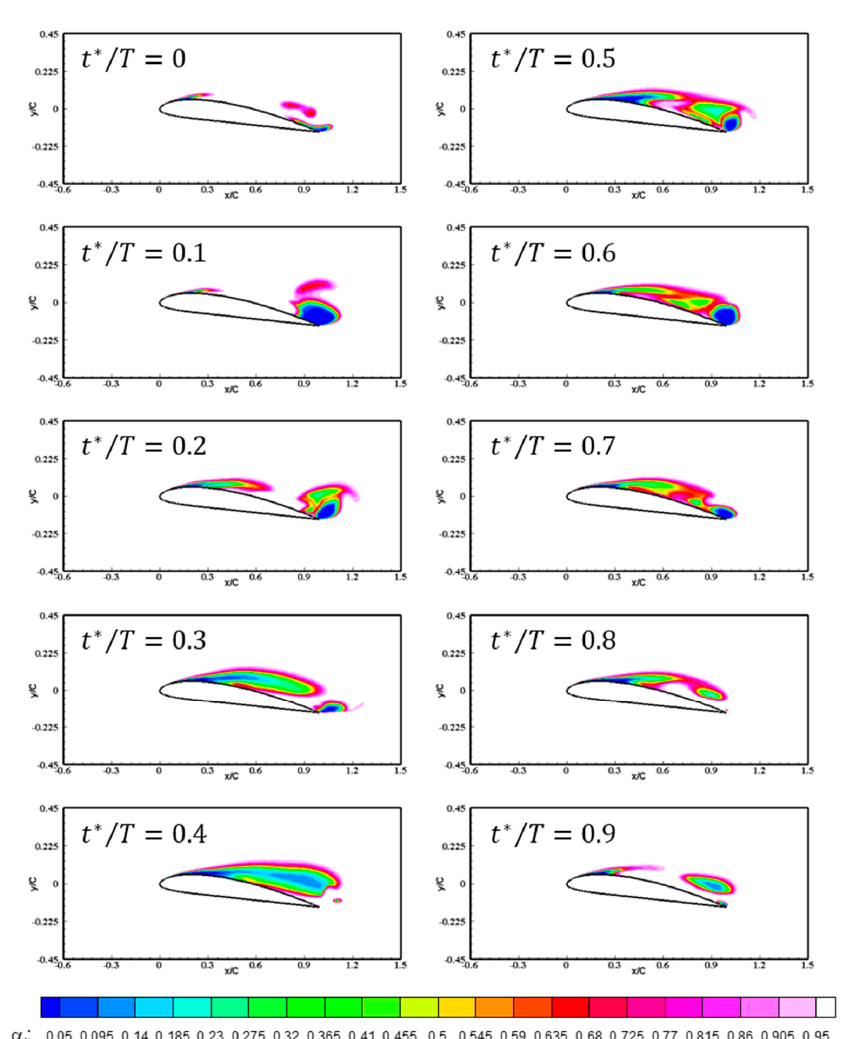
Figure 7. Time-variation of predicted liquid volume fraction in full viscous case.